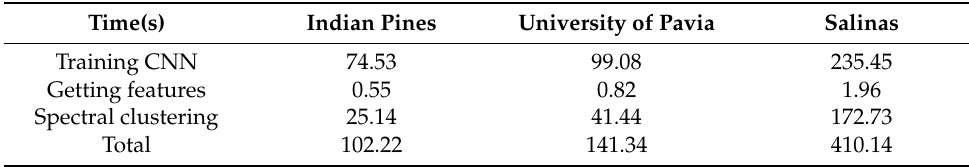
Table 10. The running time of our proposed